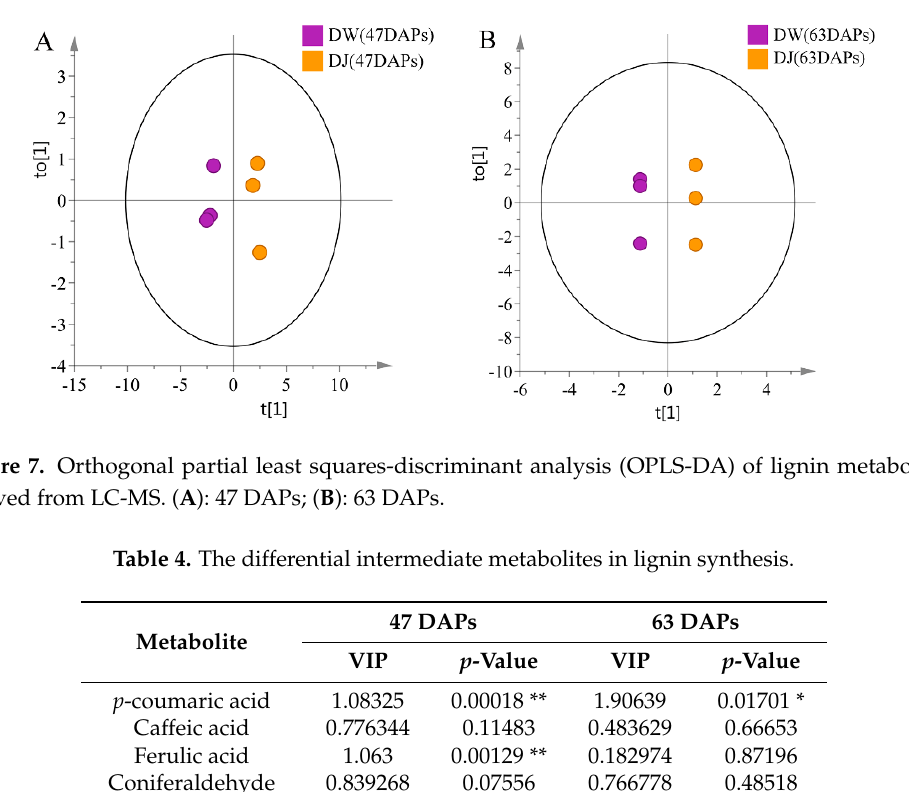
Figure 6. The lignin synthesis metabolite content in DW and DJ. Note: * represents a significant difference at the 0.05 leve (two-tailed Student’s t -test); ** represents a significant difference at the 0.01 leve (two-tailed Student’s t -test). The error bars represent standard deviations [20].